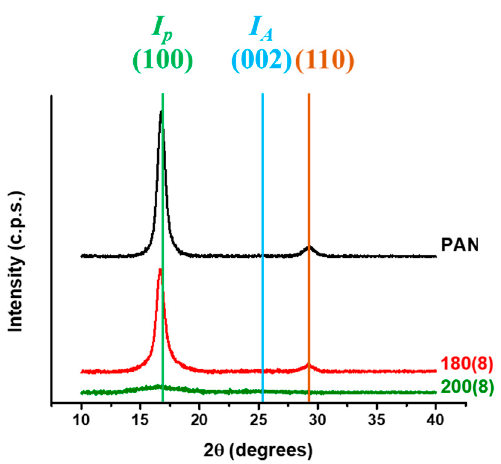
Figure 5. The variance of XRD results under different processing conditions.